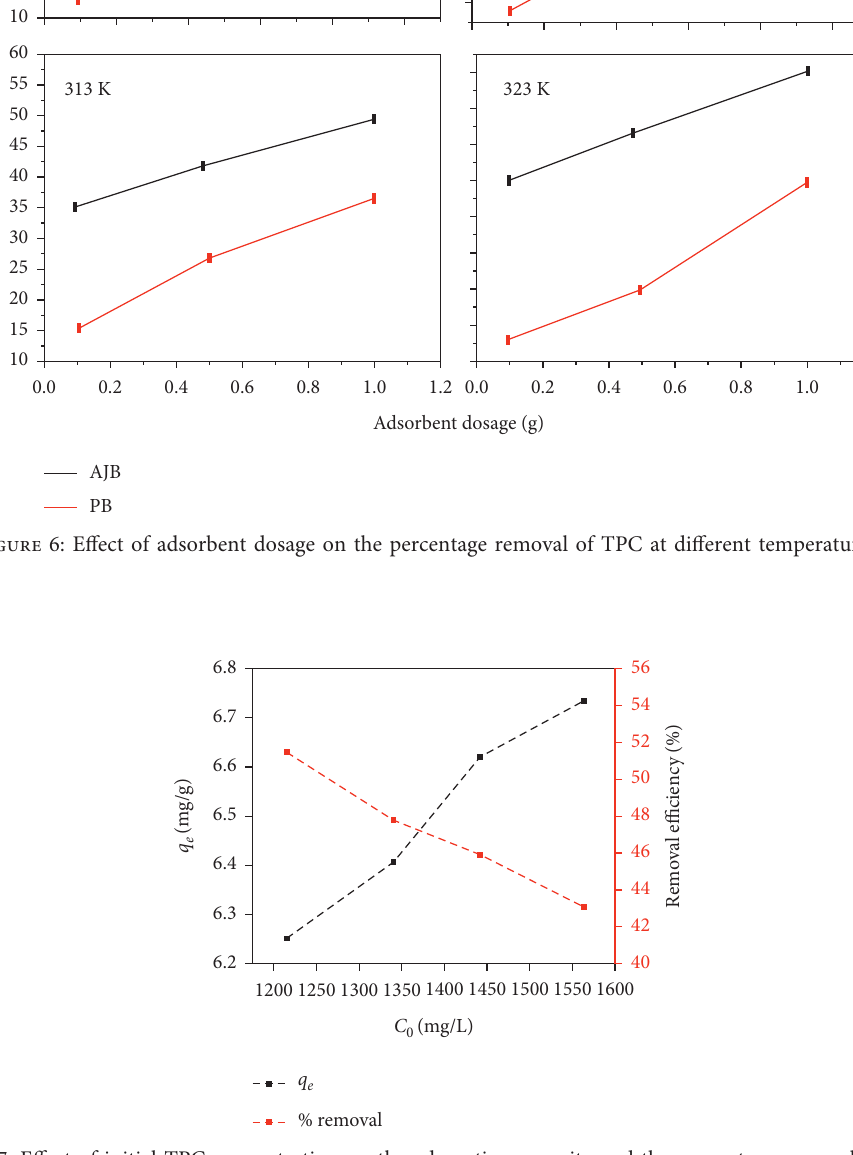
Figure 7: Effect of initial TPC concentration on the adsorption capacity and the percentage removal of